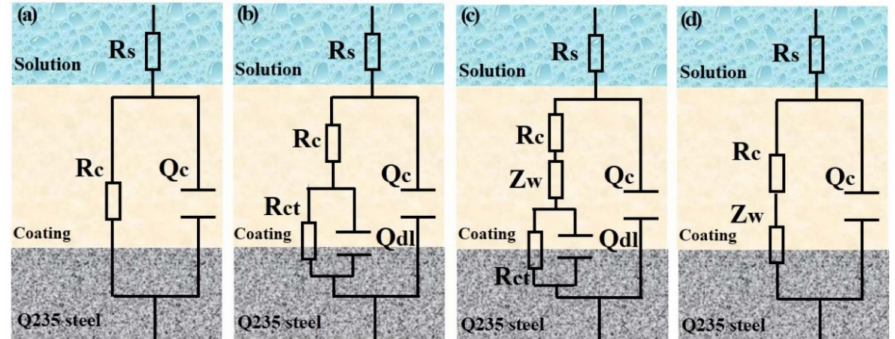
Figure 11. Electrical equivalent circuit models for composite coatings. ( a ) initial immersion, ( b , c ) midterm immersion, ( d ) coating lose e ffi cacy.